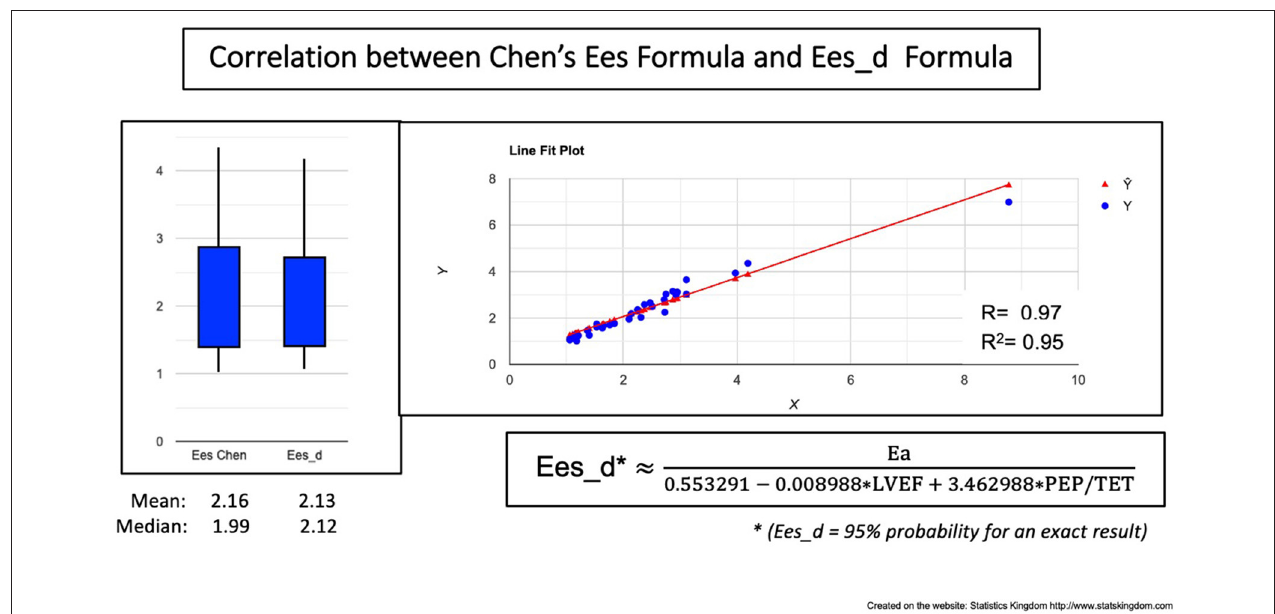
FIGURE 7 | Correlation between Chen’s formula and the VAC-Derived Ees formula (Ees_d). Left: Boxplot demonstrating the similar values; Right: Correlation